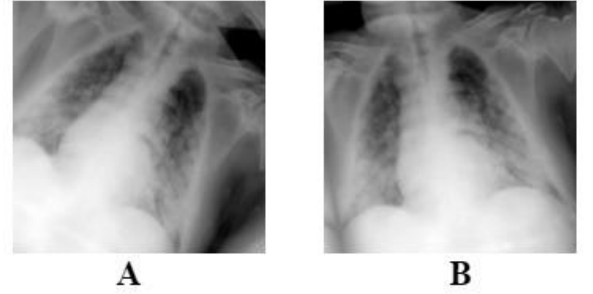
Figure 2. The figure above is an example of the augmentations that is performed on each image. Image ( A ) is flipped and rotated, and image ( B ) is only rotated slightly.